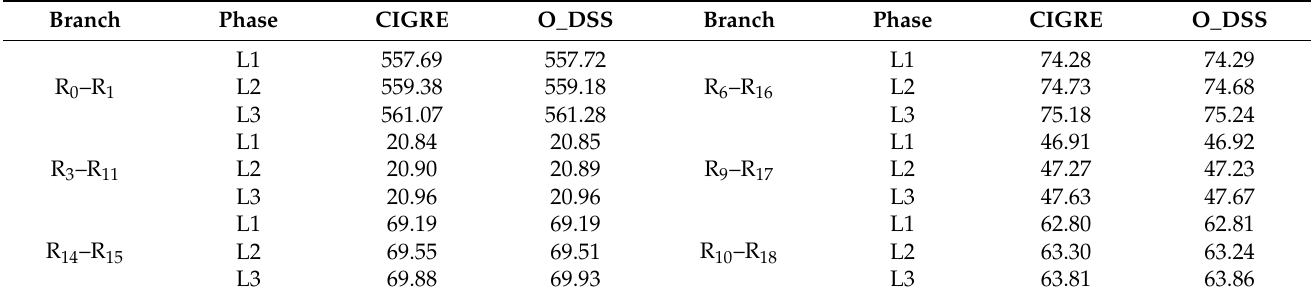
Table 4. Current flows (A) in branches that supply load buses in the CIGRE test